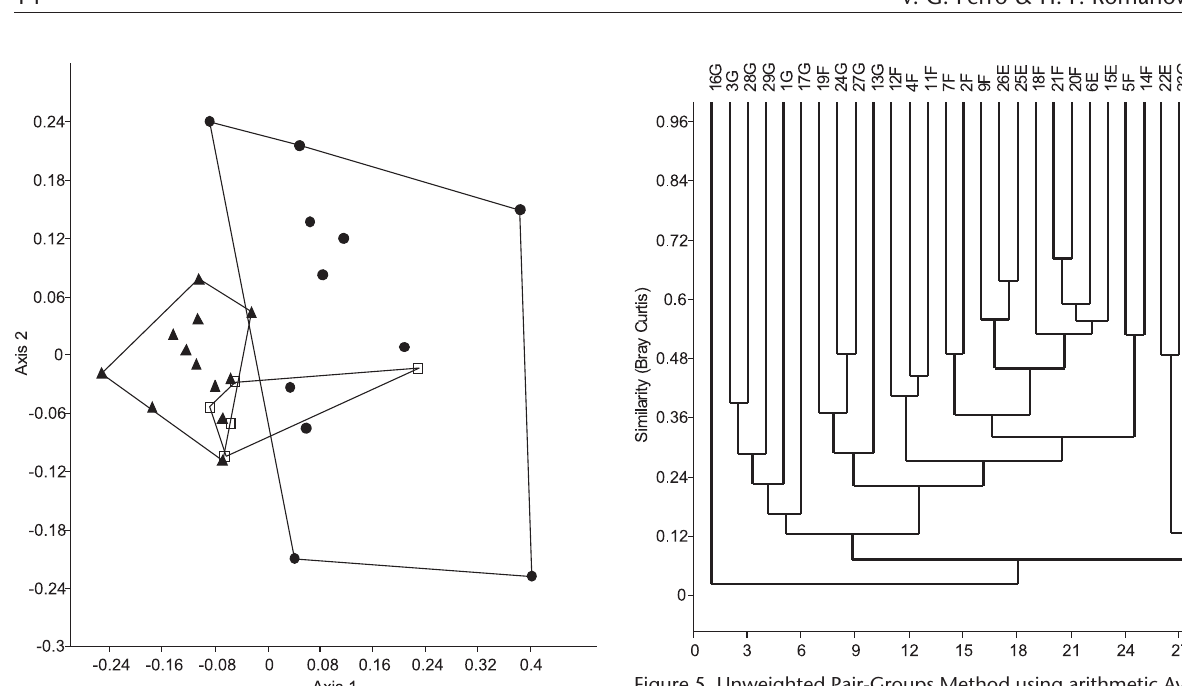
Figure 4. Non-Metric Multidimensional Scaling plot of faunal simi- larity among sites in three vegetation types in an Atlantic Forest area based on the Bray-Curtis index. Circles indicate grassland sites, triangles indicate forest sites, and squares indicate edge sites.